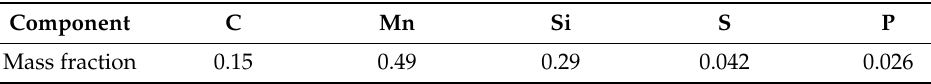
Table 2. Composition of Q235 carbon